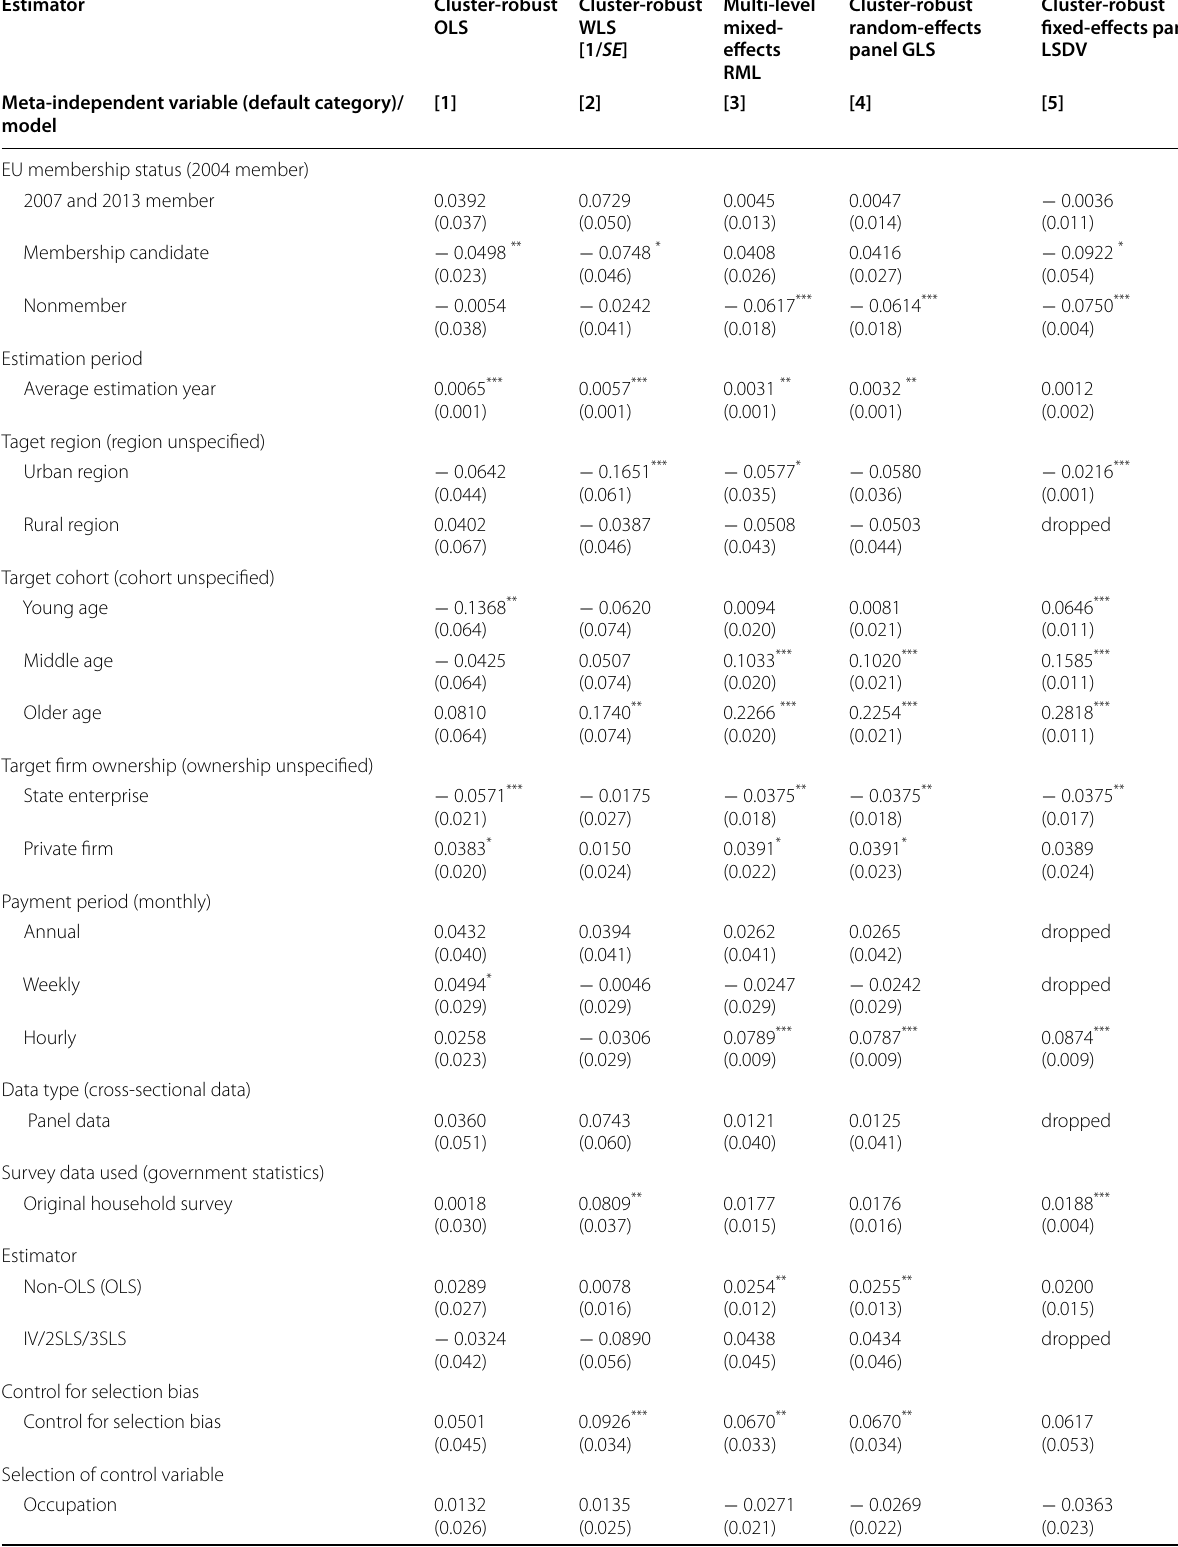
Table 4 Meta-regression analysis of literature heterogeneity: Estimation using all